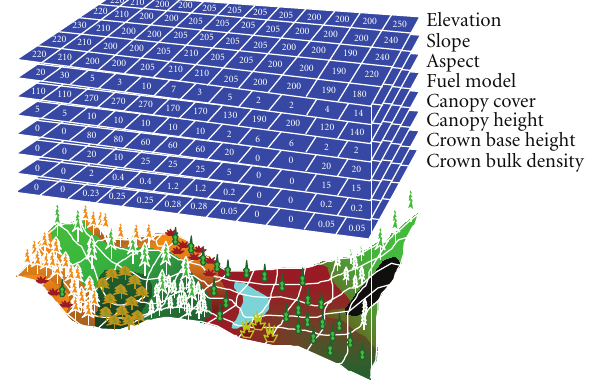
Figure 1: Fuel and topographic grid data used for wildfire simula- tions by FlamMap, FARSITE, and FSIM. The data are available from the national LANDFIRE project as ArcGIS grids. After adjustments and validation, the data are converted with ArcFuels scripts to the binary format (“LCP file”) required by these fire